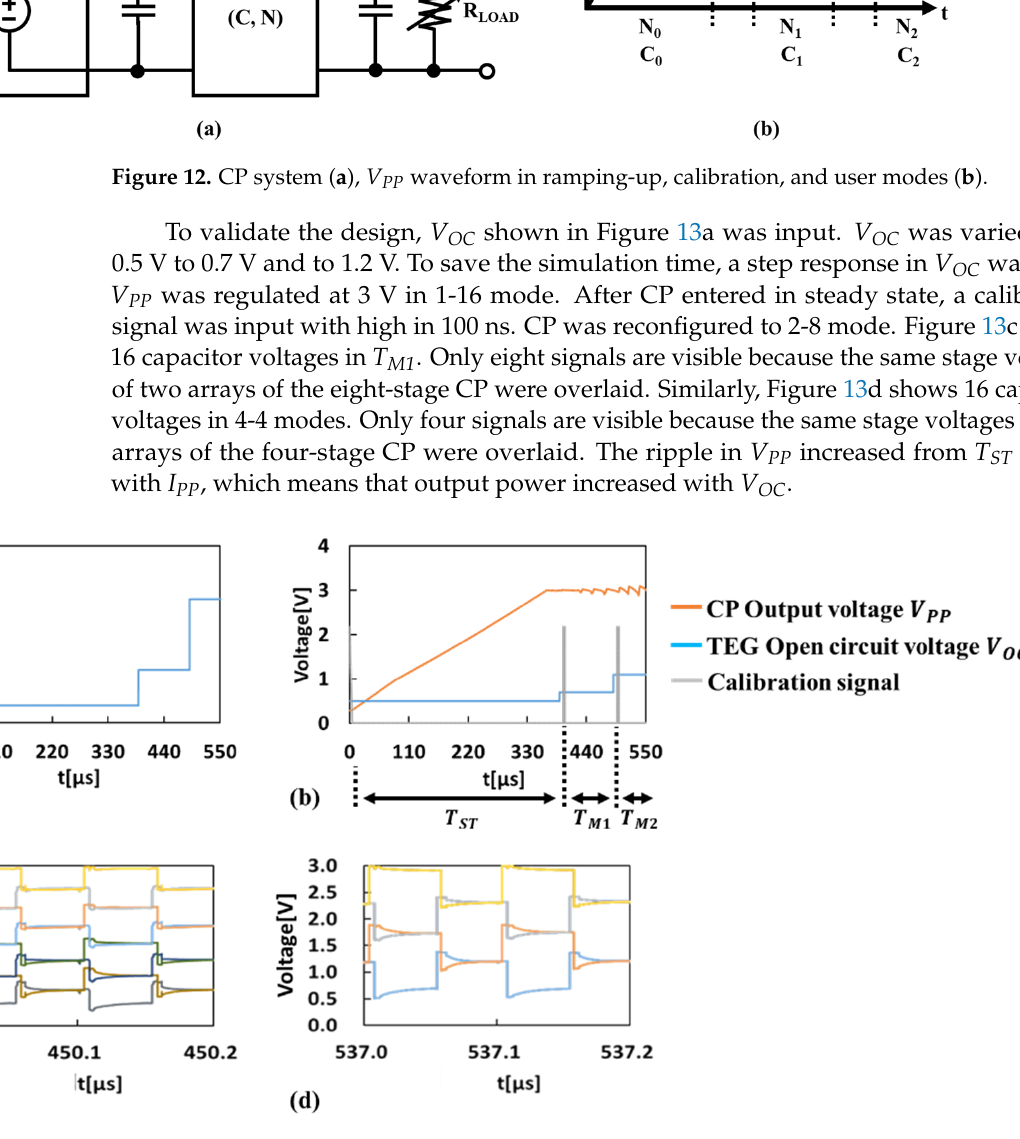
Figure 12. CP system ( a ), V PP waveform in ramping-up, calibration, and user modes ( b ).